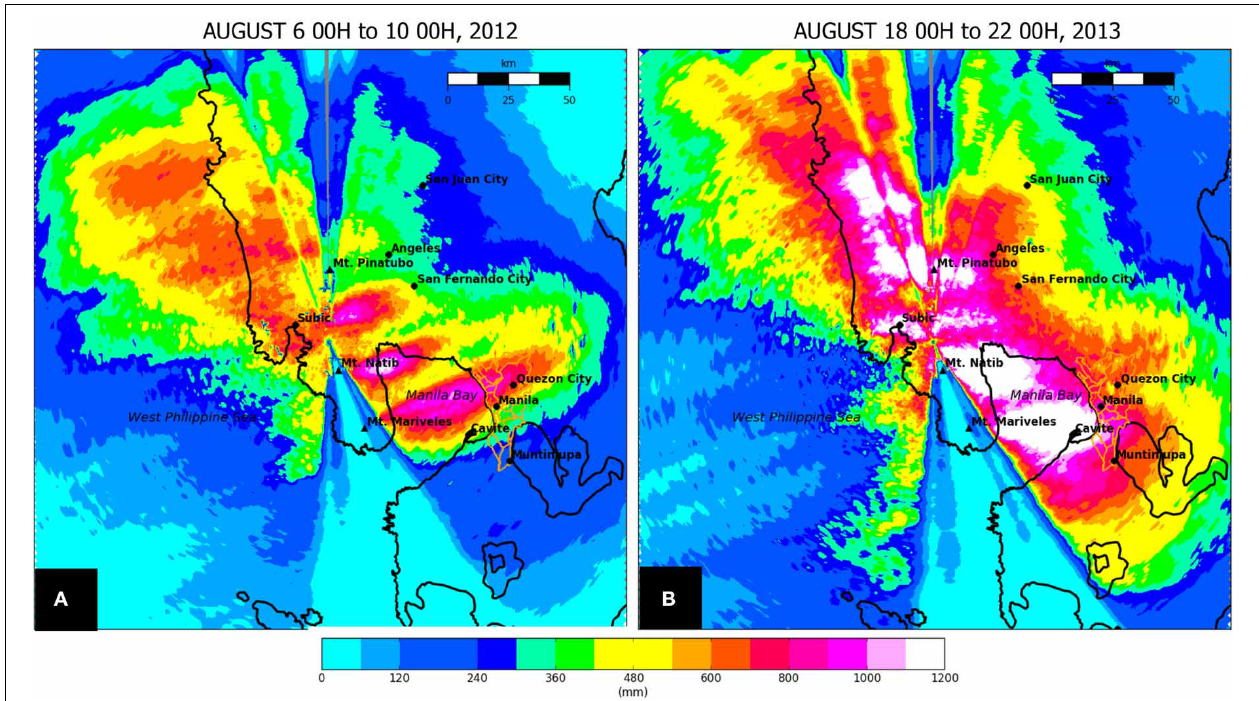
FIGURE 4 | Doppler accumulation for the (A) Habagat event of 2012 and (B) Habagat event of 2013. Plume-like patterns (dispersive tail) of high accumulated rainfall appear on the leeward side of the Mt. Natib and Mt. Mariveles